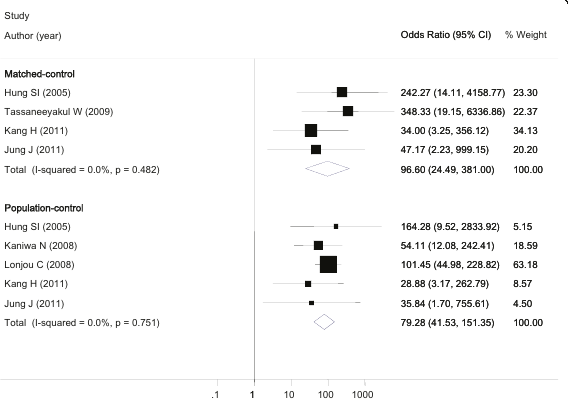
Figure 2 Forest plot . A forest plot demonstrating the association between HLA-B*5801 and allopurinol-induced SJS/TEN in matched- and population-control of included